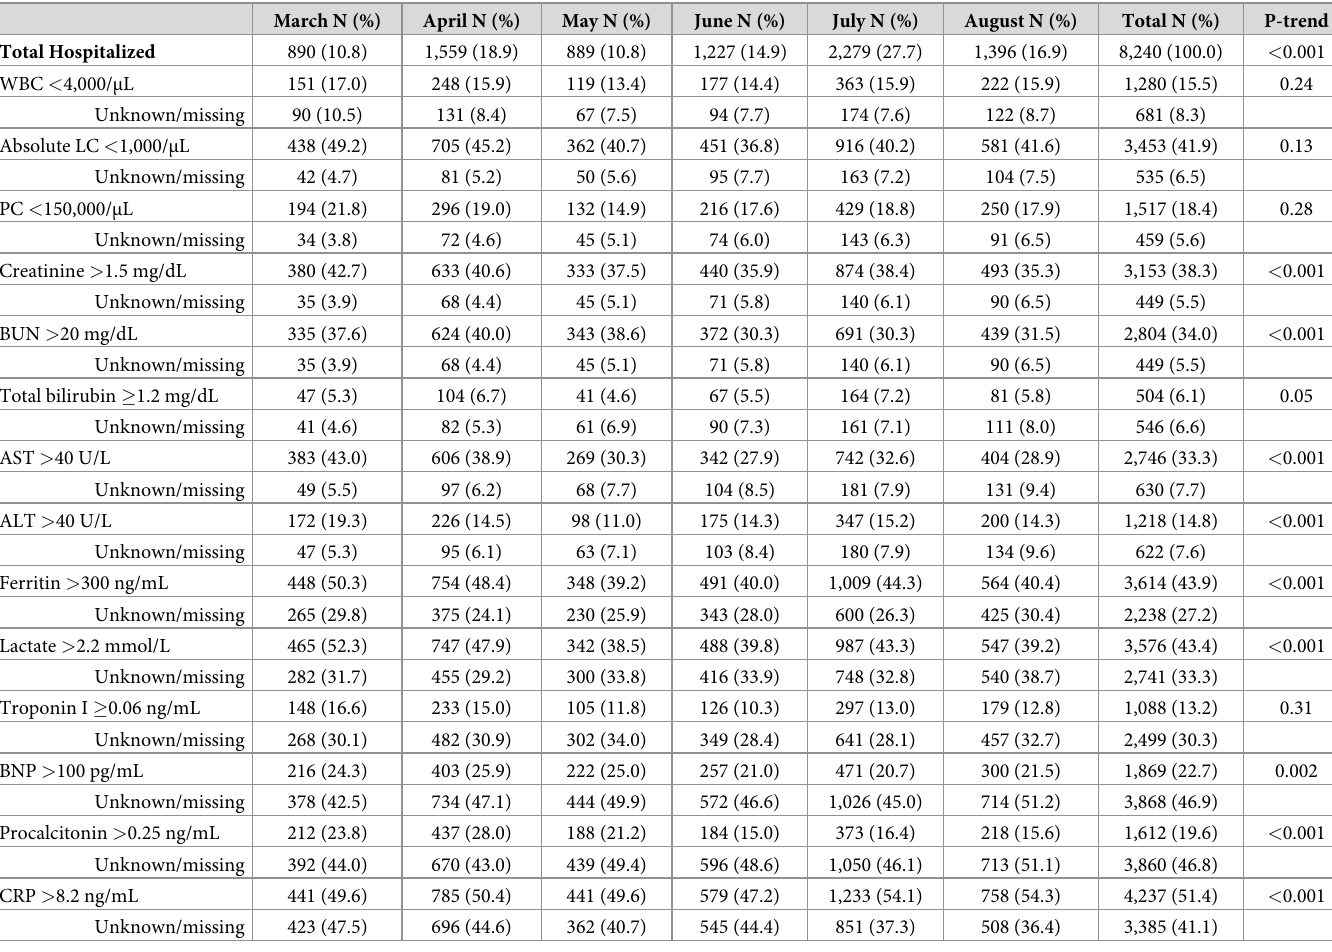
Table 4. Laboratory values � among 8,240 hospitalized Veterans Health Administration users with coronavirus disease 2019 (COVID-19), March 1, 2020 –August 31,